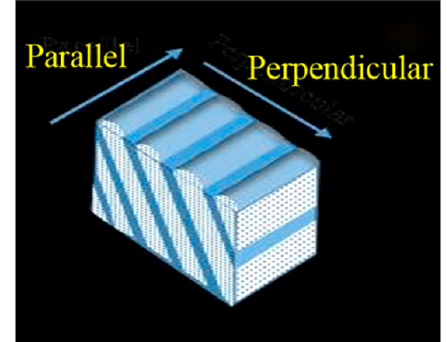
Figure 1. Drawing of the nano-morphology of the obliquely deposited Co film. The directions parallel and perpendicular, for the resistivity measurements, are shown.